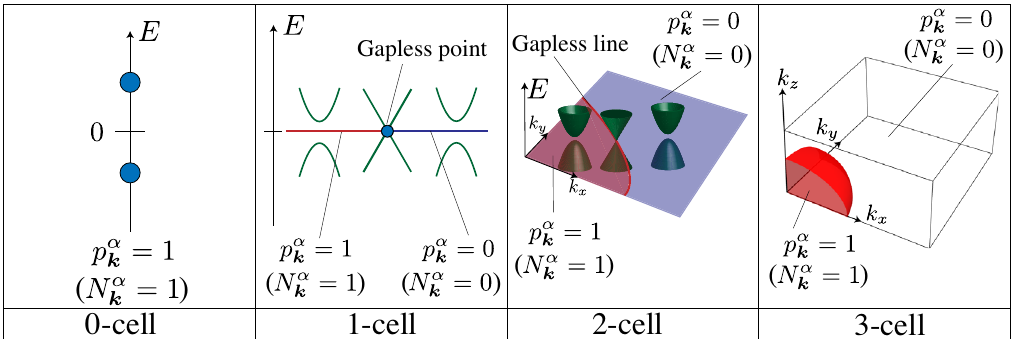
FIG. 6. Illustration of elements of E p; 0 1 . For p ¼ 0 , the elements are gapped states at 0-cells. As for p ð p ≥ 1 Þ , there are two p - dimensional regions in which the zero-dimensional topological invariants are different from each other. Since the zero-dimensional topological invariants must be the same for gapped regions, the boundary results in gapless states on p